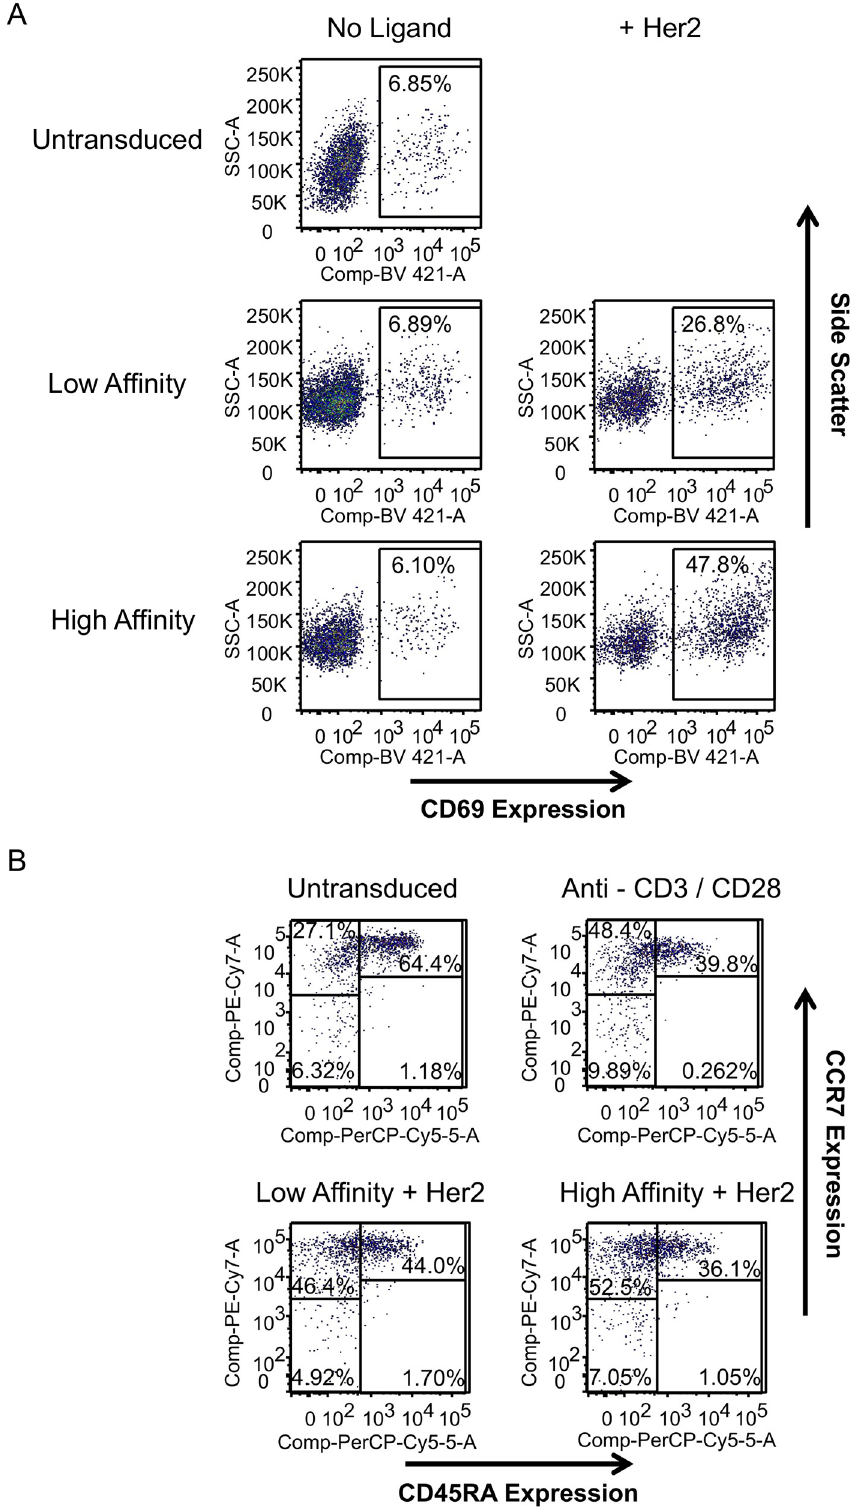
Fig 2. Signaling through chimeric antigen receptors results in T cell maturation. CD4+ T cells isolated from healthy human donors were transduced with low affinity or high affinity CARs and then allowed to return to a resting